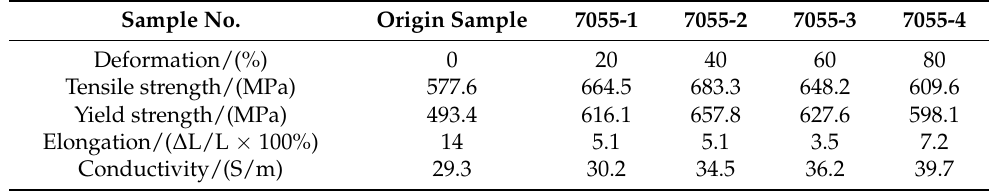
Table 5. Mechanical properties of samples.